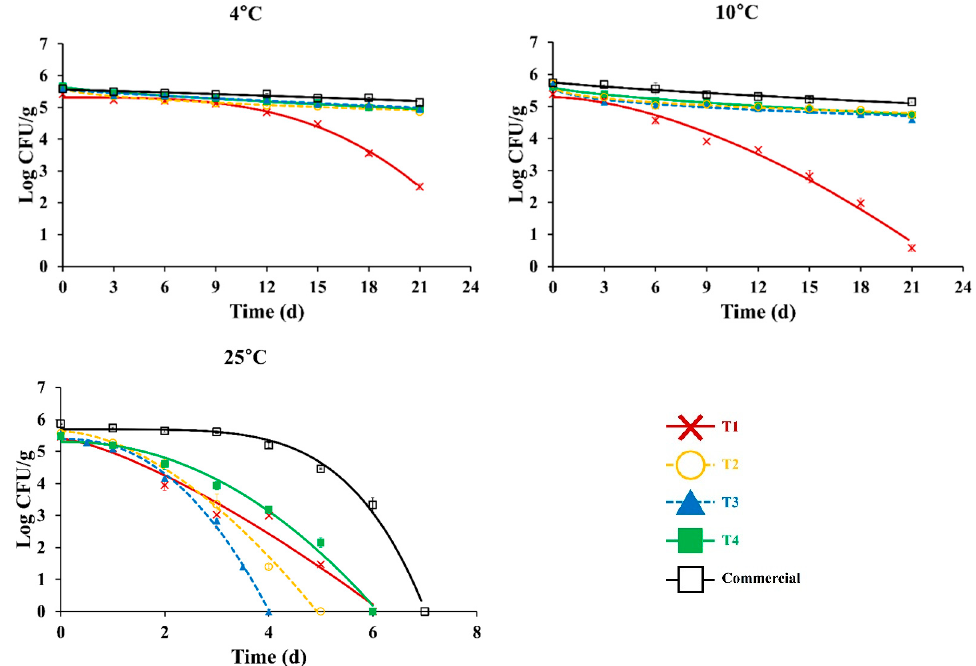
Figure 4. The effect of lactic acid bacteria on the survival of enterohemorrhagic Escherichia coli in Greek yogurt at 4, 10, and 25 °C. S. thermophilus and L. bulgaricus (T1): X , S. thermophilus, L. bulgaricus and L. gasseri BNR17 (T2): ○ , S. thermophilus, L. bulgaricus and L. planatarum HY7714 (T3): ▲ , S. thermophilus, L. bulgaricus, L. gasseri BNR17 and L. planatarum HY7714 (T4): ■ , Commercial Greek yogurt (ILDONG Foodis Plain Greek yogurt): □ . Table 2. Delta values in Greek yogurt at 4, 10, and 25 °C.